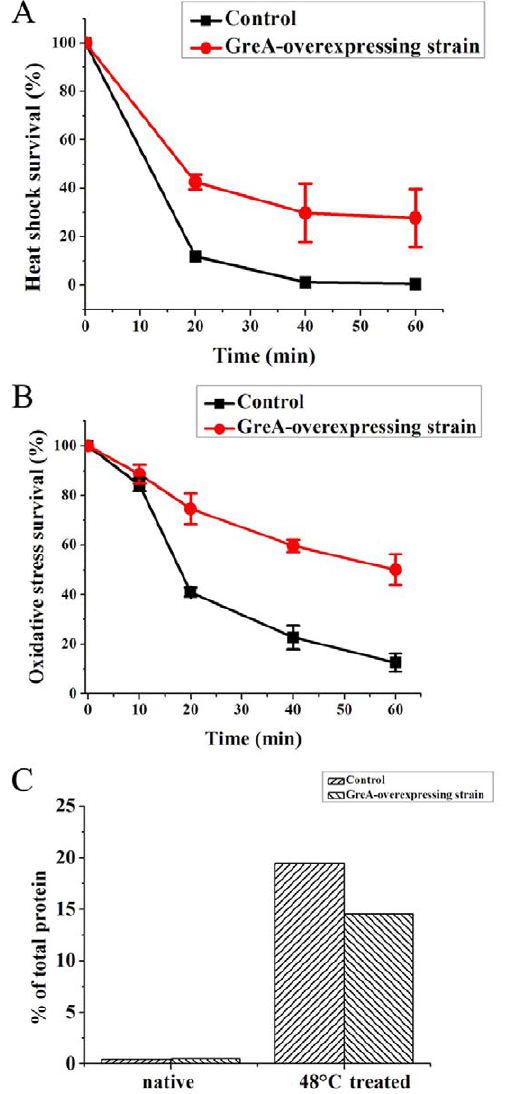
Figure 5. Enhanced resistance of the GreA-overexpressing strain to environmental stresses. (A) GreA overexpression results in enhanced heat shock survival. The IPTG-induced GreA-overexpressing strain and the control strain were both challenged by heat shock at 48 u C. The viability of cells was estimated by counting the number of surviving cells on the plates. (B) GreA overexpression confers the host strain with enhanced resistance to oxidative stress. The GreA- overexpressing strain and the control strain were both challenged with 5 mM H 2 O 2 after induction with IPTG for 1 h. Surviving cells on the plates were calculated to estimate the survival rate. (C) GreA expression suppresses cellular aggregation. The IPTG-induced strains were heat shocked at 48 u C for 0 min or 40 min, and the cellular aggregates were isolated and qualified.